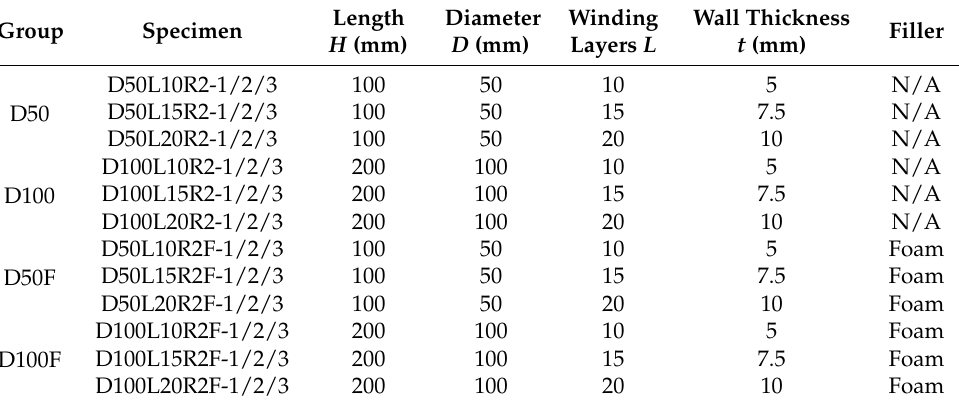
Table 3. Design parameters of the bamboo composite tube.